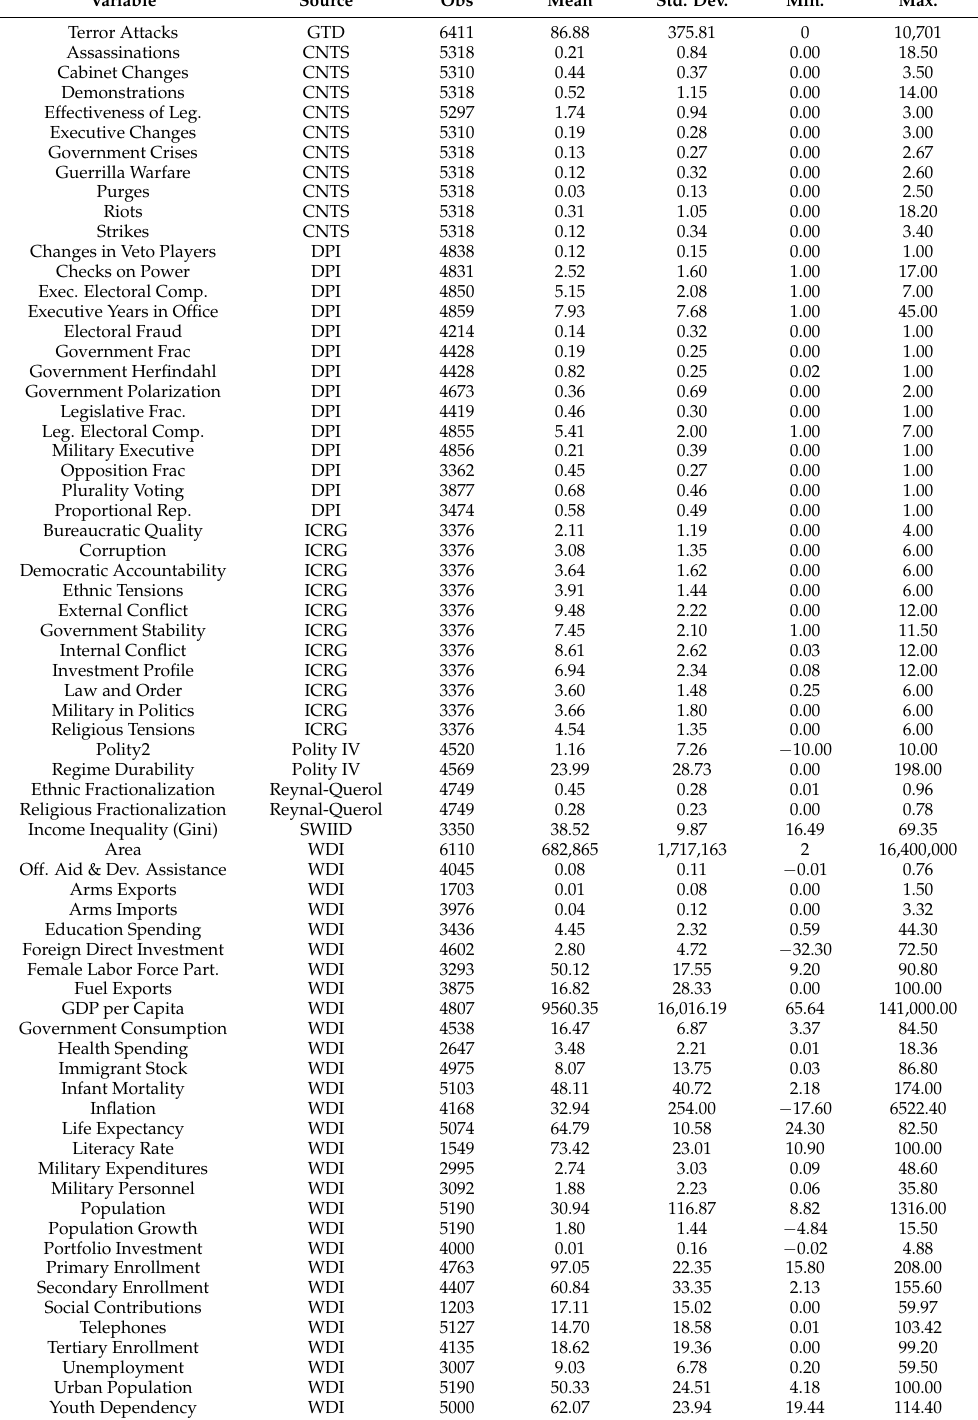
Table 1. Variables and descriptive